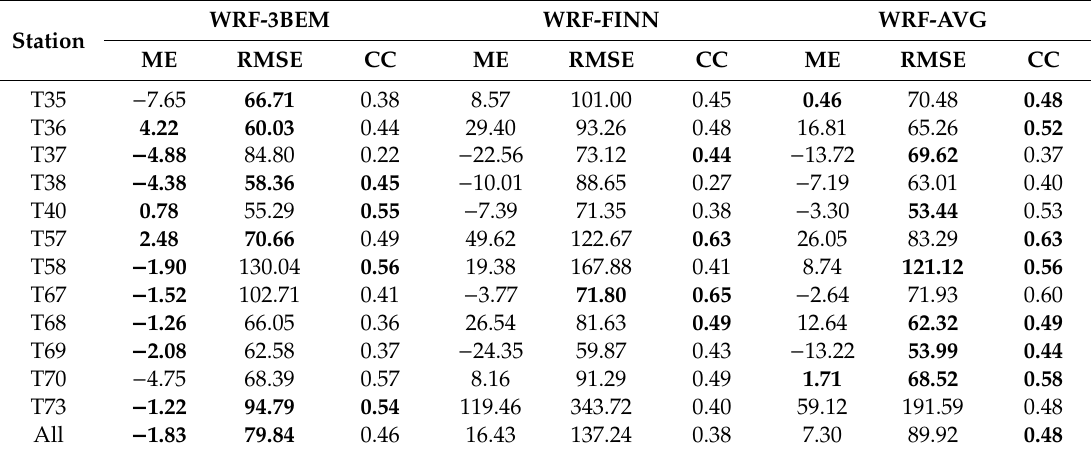
Table 3. MEs (E[simulations-measurements]), RMSEs, and CCs of simulations and measurements for